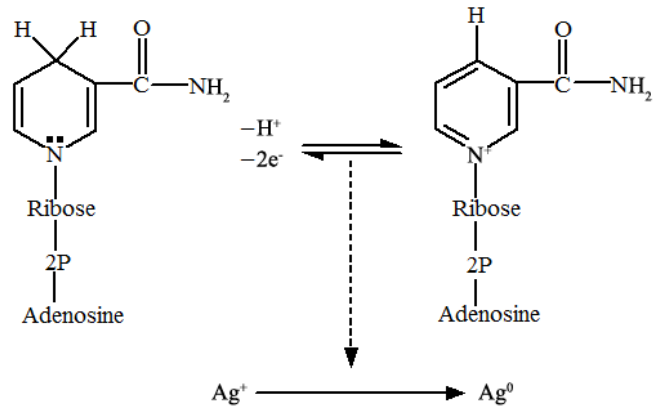
Figure 6. Schematic representation of the biosynthesis of AgNPs related to NADH, NADH-dependent reductase was also essential for the